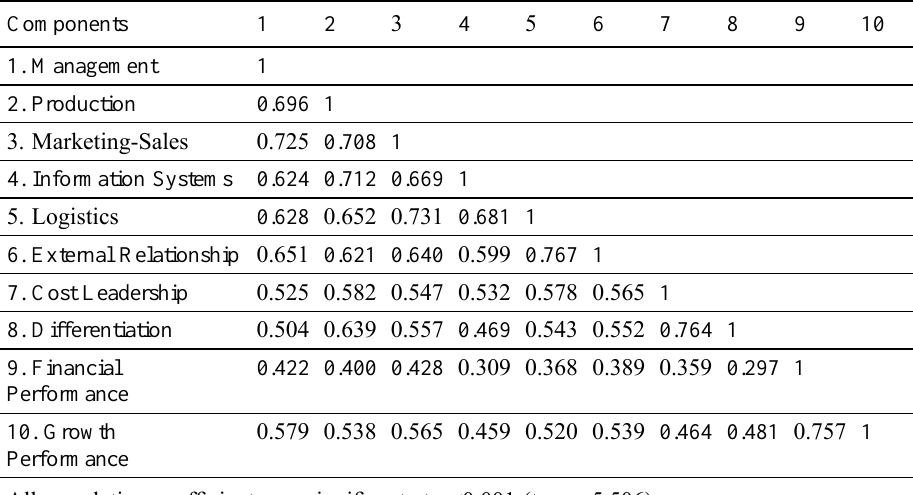
Table 4. Correlations of all factors in the research